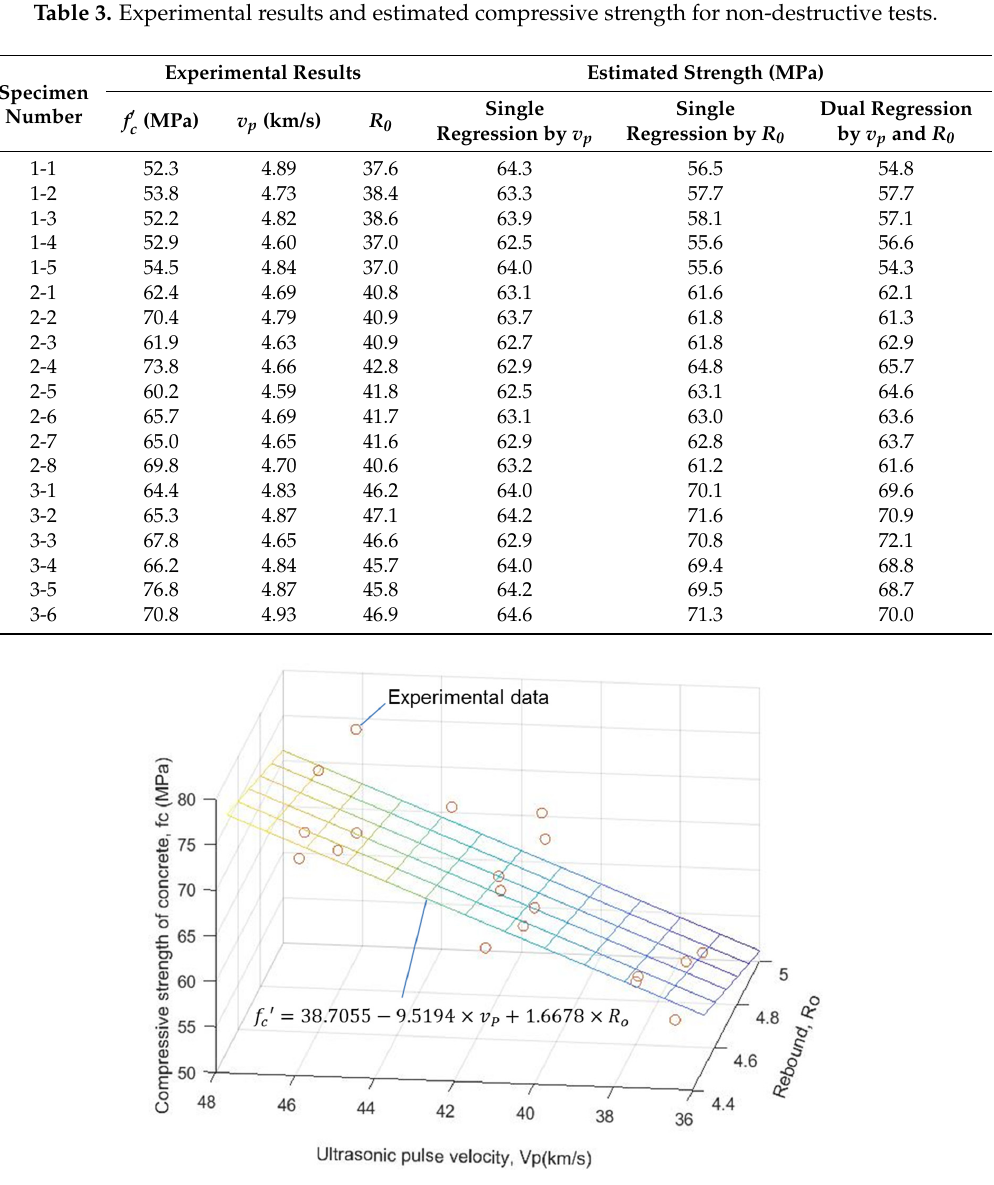
Table 3. Experimental results and estimated compressive strength for non-destructive tests.